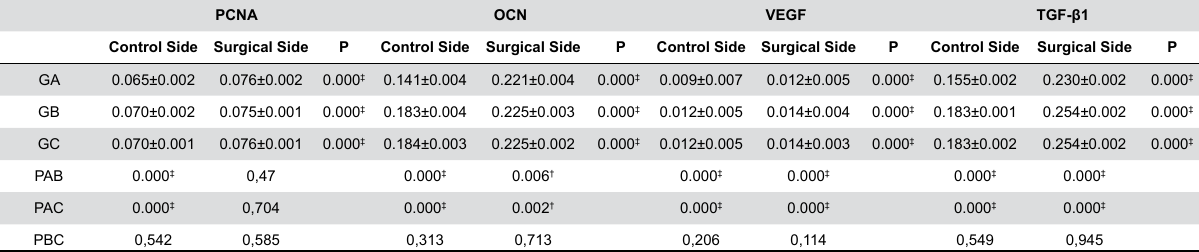
Comparison of tooth movement and biological response resulting from different force magnitudes combined with osteoperforation in Table 2- Mean optical density of the immunohistochemical items on the tension area of the moving premolar